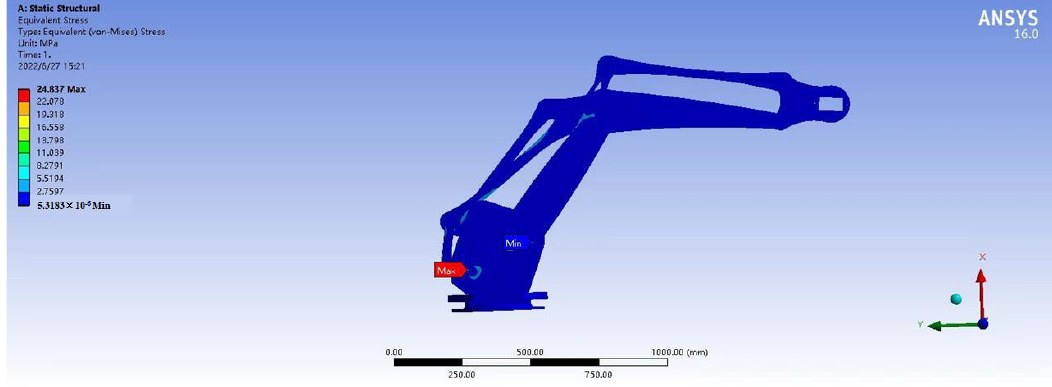
Figure 6. Manipulator’s big arm and forearm stress contour.